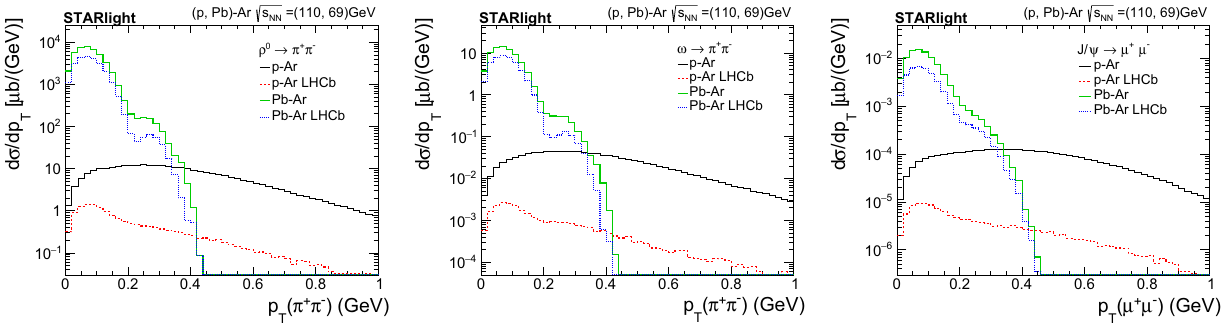
√ s = 110 and 69 GeV,